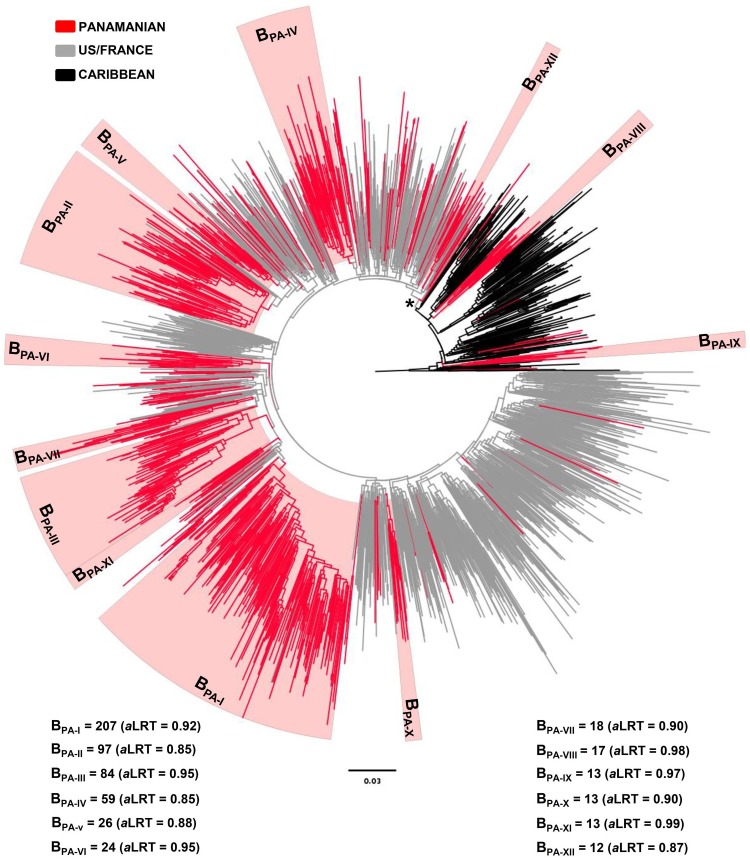
ML phylogenetic tree of HIV-1 subtype B pol (∼1000 pb) sequences circulating in Panama (n = 761), and representative sequences of the BPANDEMIC (US = 465, France = 344) and the BCAR (Caribbean = 238) clades.Branches are colored according to the geographic origin of each sequence, as indicated at the legend (top left). Red shaded boxes highlight the position of the twelve major Panamanian HIV-1 subtype B clades (BPA-I to BPA-XII). The number of sequences and the aLRT support values for each clade are indicated at bottom. Asterisk indicates the node of the BPANDEMIC clade. The tree was rooted using HIV-1 subtype D reference sequences. The branch lengths are drawn to scale with the bar at the bottom indicating nucleotide substitutions per site.